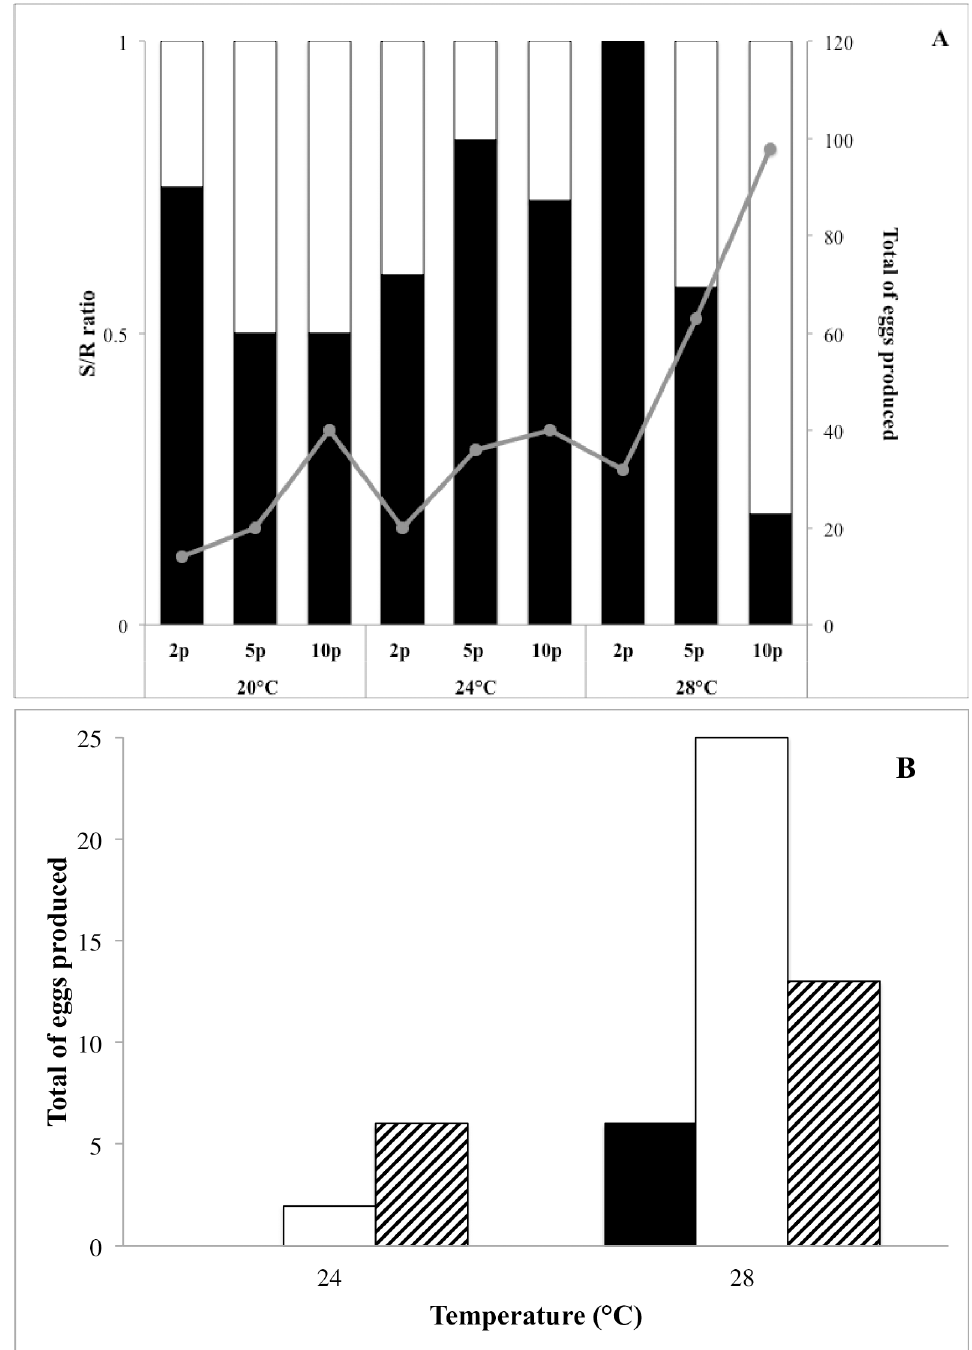
Fig 3. Proportion of subitaneous and resting eggs in Mesostoma ehrenbergii (A) where open bars, filled bars and filled circles correspond to subitaneous eggs, resting eggs and total number of eggs; and (B): total number of eggs produced by Mesostoma craci at different temperatures and prey densities. Filled, open and dashed bars correspond to 2, 5 and 10 prey.